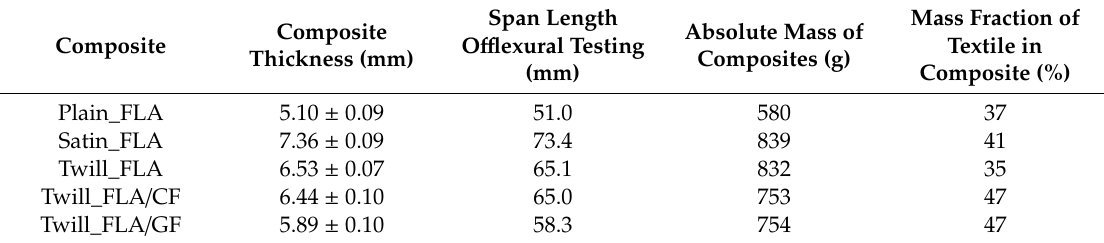
Table 5. The height and the corresponding span during the testing of the flexural